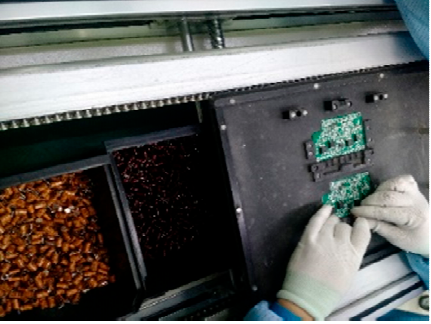
Figure 2. Manual assembly. Figure 2. Manual